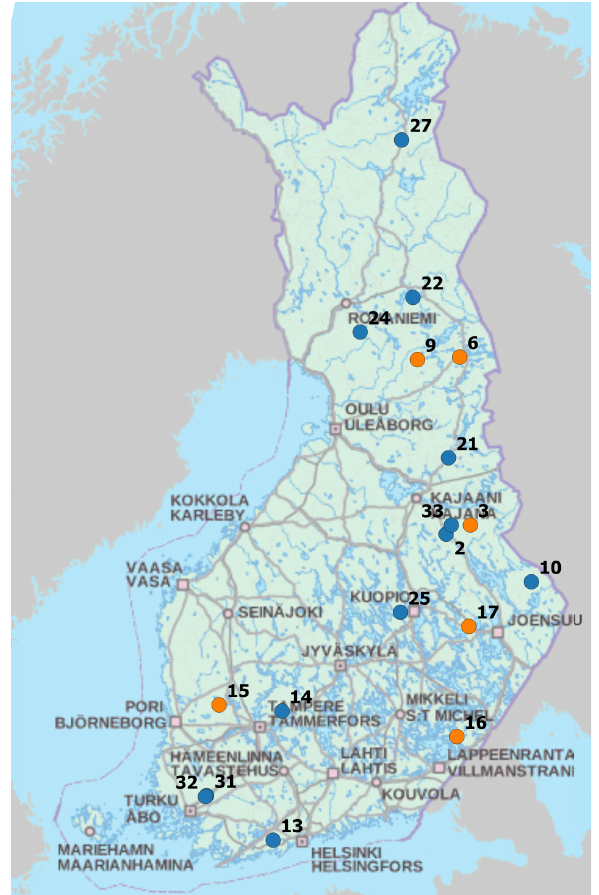
Figure 1. Location of calibration catchments (blue dots) and test catchments (orange dots) extends from Southern to Northern Finland. The catchment properties are described in Tables 1 and A1. The distance from the northernmost to the southernmost border of Finland is 1150